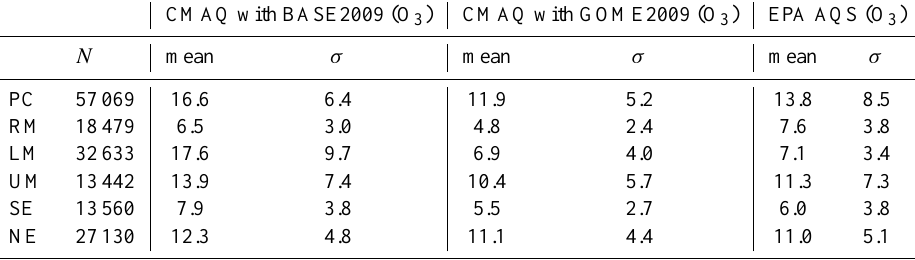
Table 2. The total number, the mean, and the standard deviation of the EPA AQS NO x observations (inppbv), CMAQ NO x simulations with the base emissions, BASE2009 and CMAQ NO x simulations with the GOME-2 adjusted emissions, GOME2009 at the EPA AQS NO x measurement sites over six geological regions of the US (PC: Pacific Coast, RM: Rocky Mountain, LM: Lower Middle, UM: Upper Middle, SE: Southeast, and NE: Northeast). CMAQ with BASE2009 (O 3